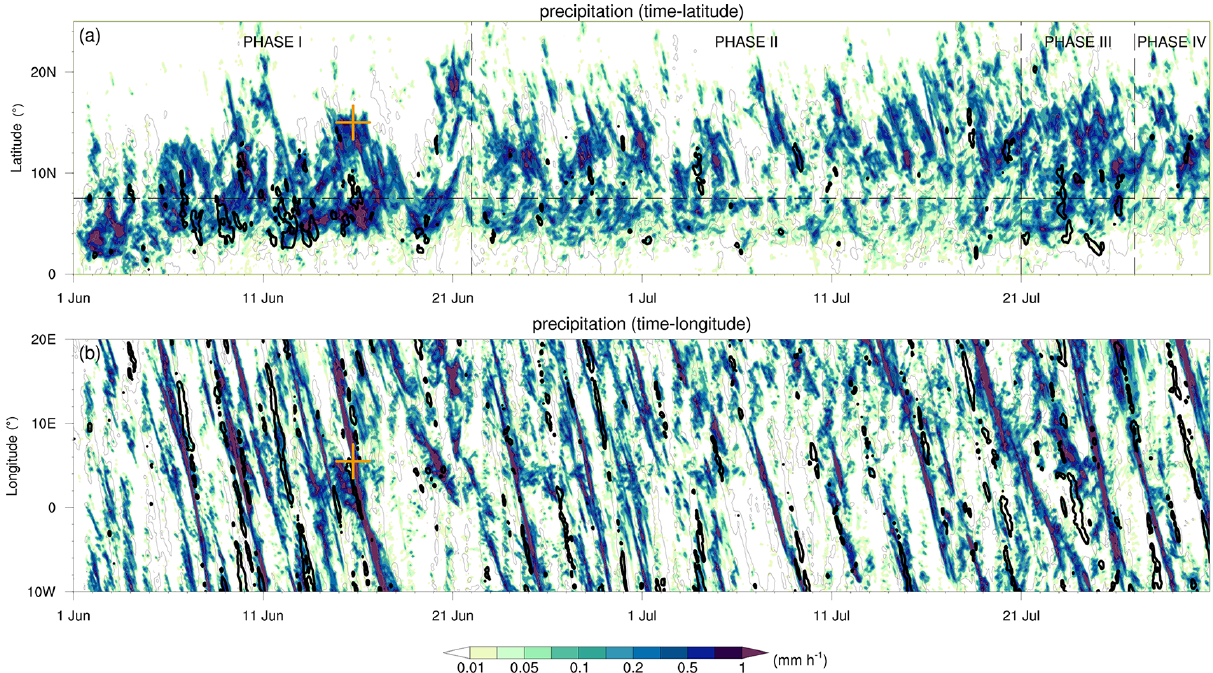
Figure 4. The temporal evolution of precipitation from EXPL7 and GPM IMERG during the June–July 2016 period. The panels show precipitation (mmh − 1 ) from EXPL7 (colours) and from GPM IMERG at 0.1mmh − 1 (thin grey contours) and 1.0mmh − 1 (thick black contours) (a) as a function of time and latitude averaged over the longitude band of 10 ◦ W to 20 ◦ E and (b) in a Hovmöller diagram averaged over the latitude band from 5 to 20 ◦ N. The four phases in panel (a) refer to the WAM stages discussed in Sect. 3.3, and the orange markers in panels (a) and (b) denote the time and location of the MCS discussed in the case study in Sect. 4.1.